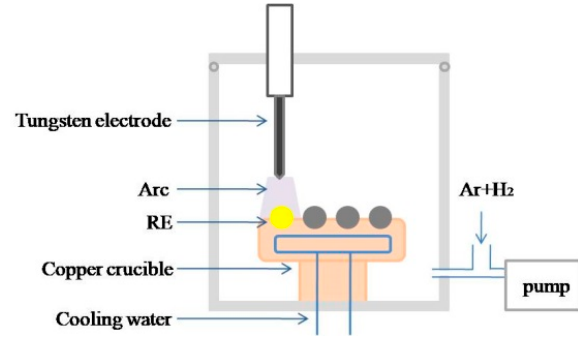
Figure 7. Schematic diagram of hydrogen plasma arc melting.